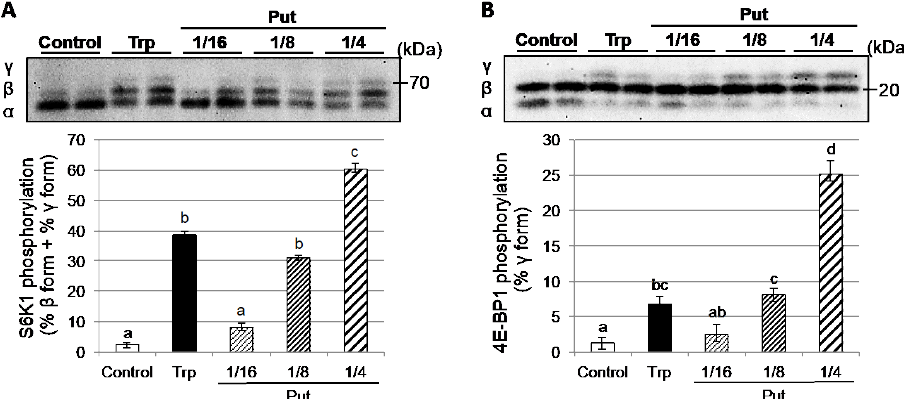
Figure 5. E ff ects of putrescine administration on hepatic protein synthesis. Liver lysates were subjected to SDS–PAGE, and the phosphorylation states of S6K1 and 4E-BP1 determined by immunoblot analysis. During SDS–PAGE, S6K1 and 4E-BP1 were resolved into multiple isoelectric forms based on its phosphorylation state. The rapidly migrating band was arbitrarily designated α , and the more slowly migrating bands as β and γ , as indicated in the blot image. ( A ) The phosphorylation of S6K1 was expressed as the amount of S6K1 in the β and γ forms as a percentage of total S6K1 ( α + β + γ ). ( B ) The phosphorylation of 4E-BP1 was expressed as the amount of protein present in the γ -form as a percentage of total 4E-BP1 ( α + β + γ ). Results represent mean ± SEM, n = 5. Values not sharing the same letter are significantly di ff erent ( p <